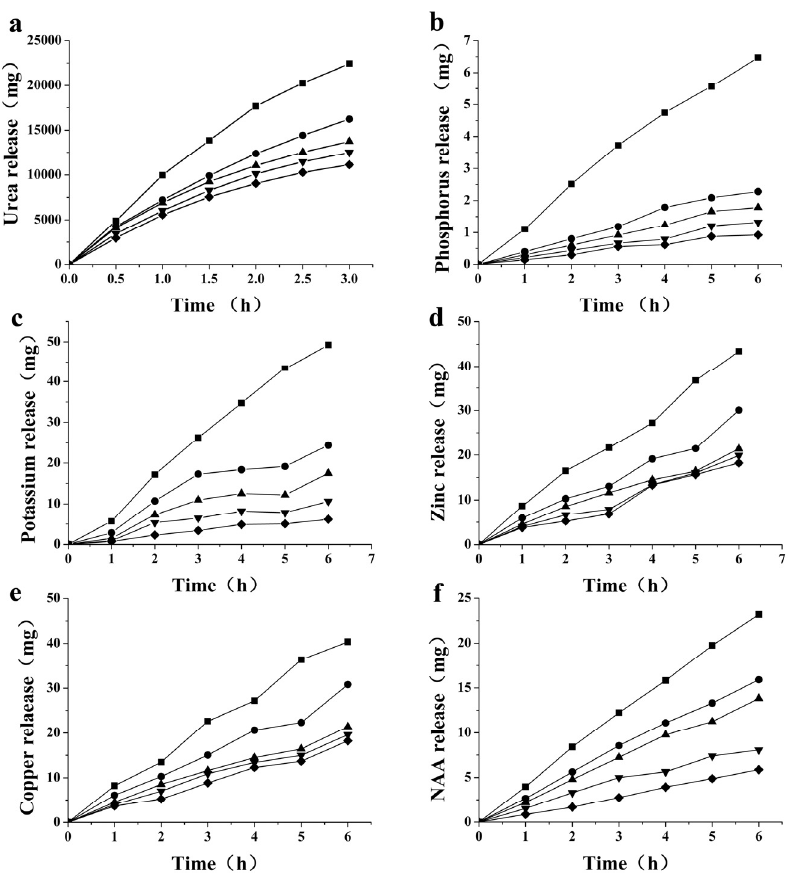
Figure 5. ( a ) urea; ( b ) phosphorus; ( c ) potassium; ( d ) zinc; ( e ) copper; ( f )